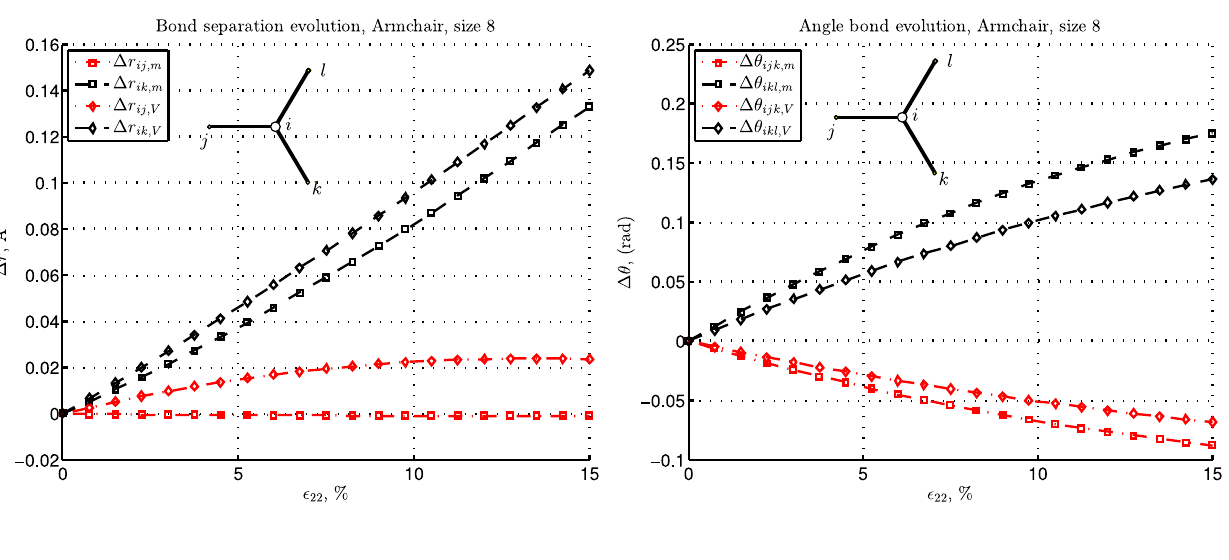
Figure 9. The pair bond separation (left) and angular bond (right) evolution with respect to strain increase is presented for zigzag